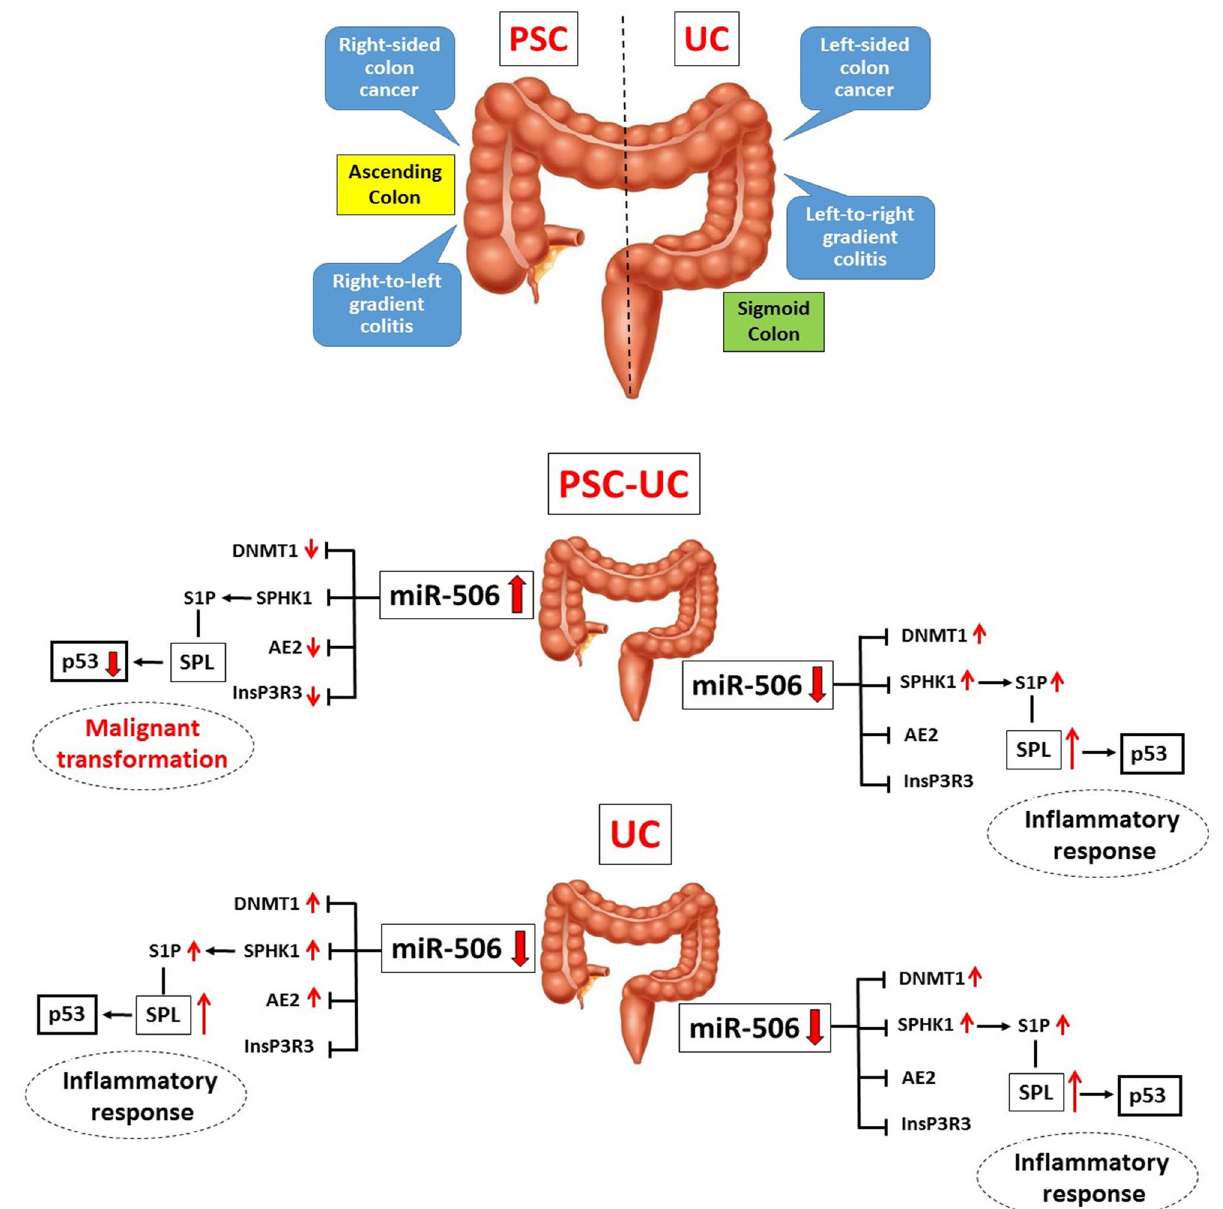
Figure 6. Schematic figure showing the possible contribution of miR-506 to phenotypic presentation of colitis in patients with PSC + UC compared to those with UC alone. MicroRNA-506 expression was upregulated in ascending colons of patients with primary sclerosing cholangitis and concurrent ulcerative colitis (PSC + UC). This overexpression of miR-506 resulted in reduced expression of anion exchange protein 2 (AE2) and inositol- 1,4,5-trisphosphate-receptor (InsP3R3), which destabilized protection against toxic bile acids. The lack of sphingosine-kinase-1 (SPHK1) induction in the face of increased inflammation in this part of the colon, as well as the loss of sphingosine-1-phosphate lyase (SPL) activity, promoted neoplastic transformation via a p53-dependent pathway. In contrast, colonic suppression of miR-506 in both parts of UC patient colons, and in the sigmoid colons of PSC + UC patients, was accompanied by a substantial increase in SPHK1 expression. The enhanced levels of kinase SPHK1 resulted in upregulation of bioactive sphingosine-1-phosphate (S1P) which led to further activation of S1P-dependent signaling pathways. The net effect of these responses is severe inflammation. S1P is continuously and irreversibly degraded by the SPL enzyme, which is abundantly expressed in enterocytes, protecting from colitis-associated